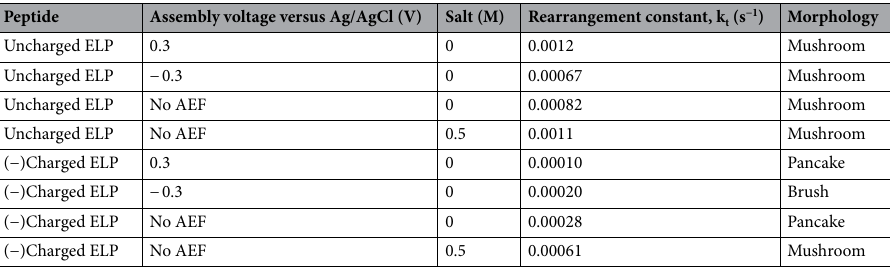
Table 2. The morphology of ELP grafted on gold is impacted by hydrophobicity/charge, rearrangement kinetics and AEF. The conditions of peptide grafting experiments are described (peptide type, assembly voltage, and presence of salt) along with their impact on the rearrangement constant (k t ) and grafted ELP morphology.